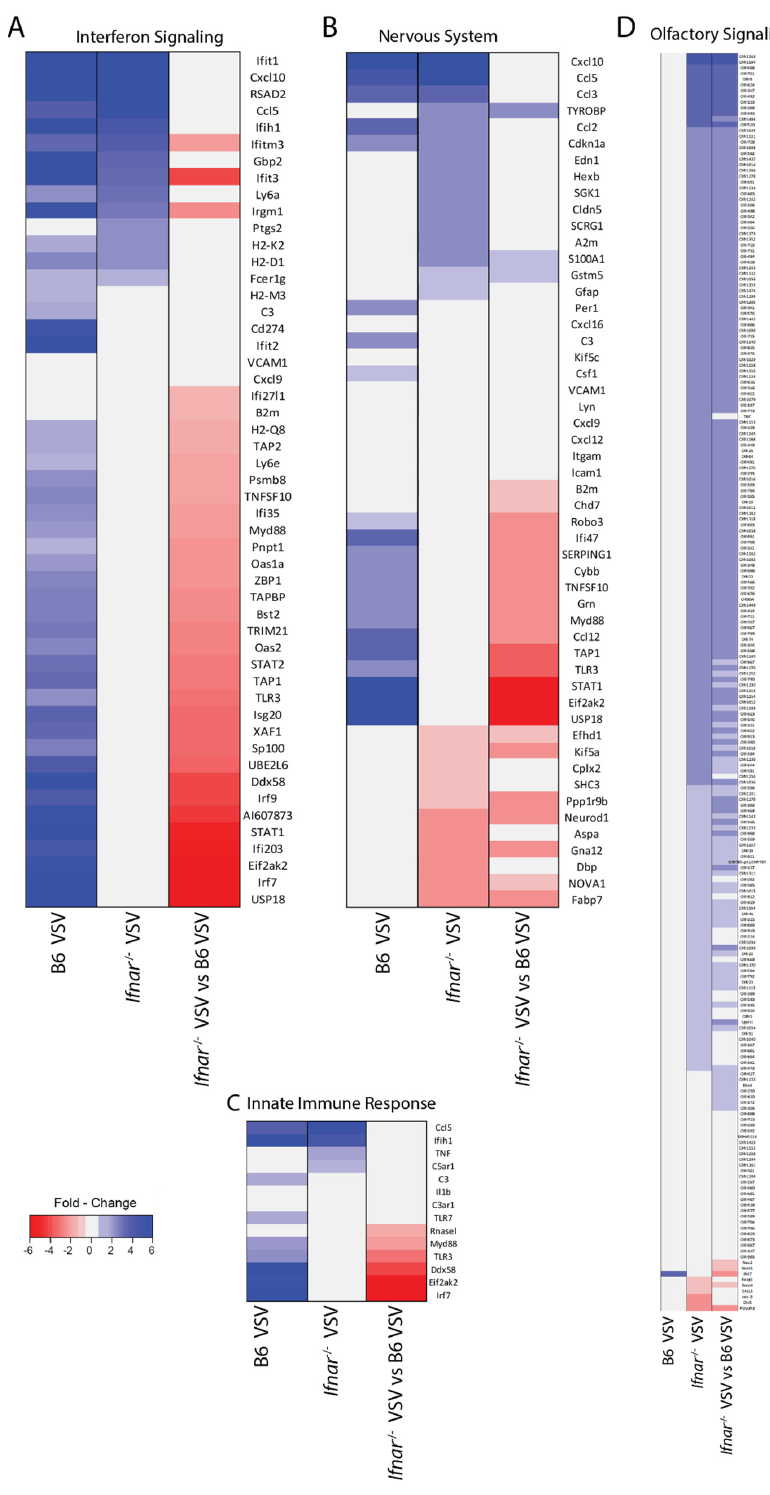
Figure 6. Massive gene expression in the absence of IFN-I signaling during VSV infection. Representative heat maps are shown to di ff erentially regulate genes ( p < 0.05, fold expression > 1.5) in the absence of the IFN-I signaling associated with the ( A ) IFN signaling, ( B ), nervous system, ( C ), innate immune response, and ( D ) olfactory related signaling genes at day two post-infection. TheaforementionedfunctionwasassignedtoageneusingtheIngenuityPathwayAnalysis(IPA)analysis tool. Blue nodes = upregulated genes, red nodes = downregulated genes, gray nodes = no